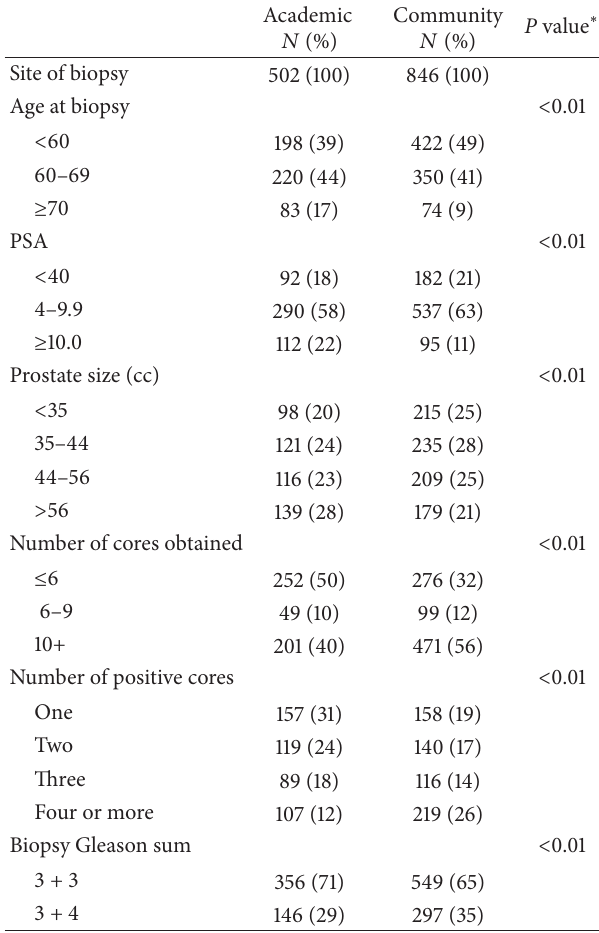
Table 1: Distribution of clinical and biopsy characteristics between community and academic